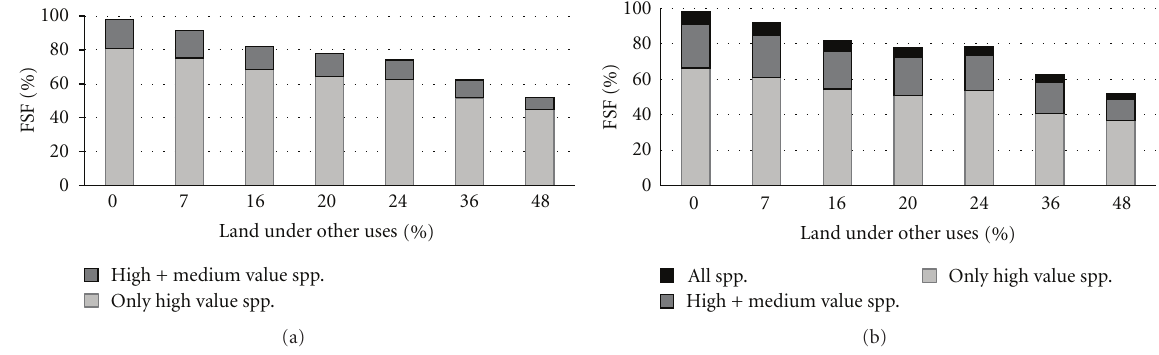
Figure 2: Percentage of stands harvested within Faro State Forest with an increasing number of stands converted to other land uses from current logging centers (a) and from closer urban centers (b).